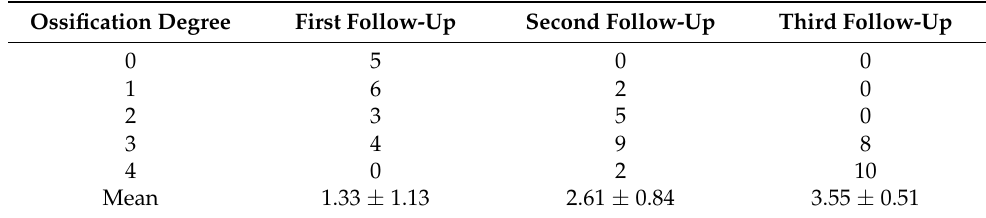
Table 2. Number of patient per follow-up for ossification degree assessment. Ossification Degree